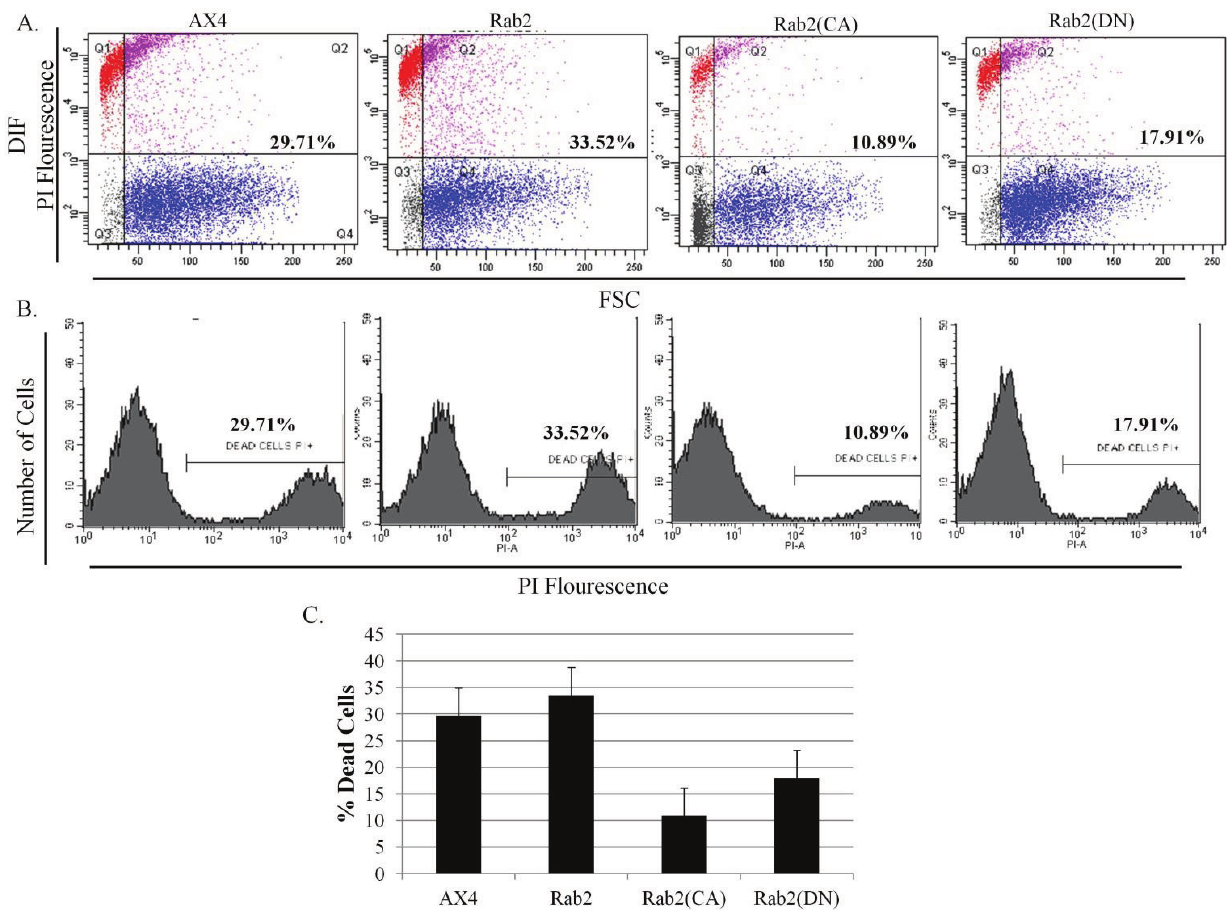
Figure 6. Cell death levels are reduced in cells over-expressing mutant forms of DdRab2. ( A – C ) Cell death quantification using flow cytometry analysis. Data are the result of three independent experiments with a p -value > 0.05 ( A ) WT-Ax4, Rab2 over-expressing, Rab2(CA), and Rab2(DN) cells were subjected to starvation and cAMP, and incubated